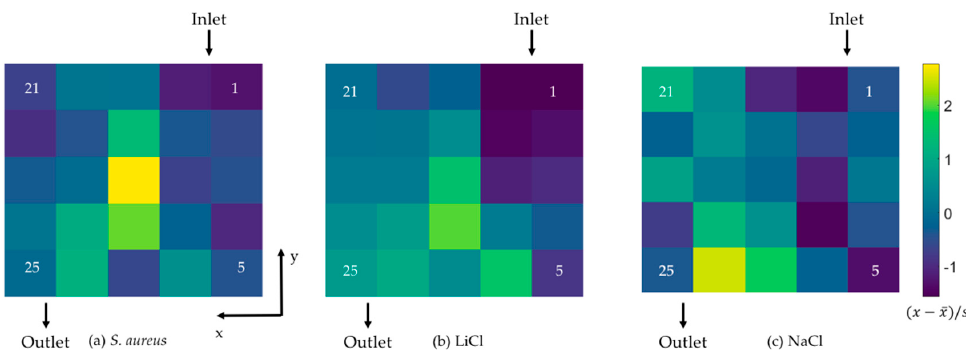
Figure 3. Floor spatial deposition maps of ( a ) normalized S. aureus ; ( b ) normalized LiCl; ( c ) normalized